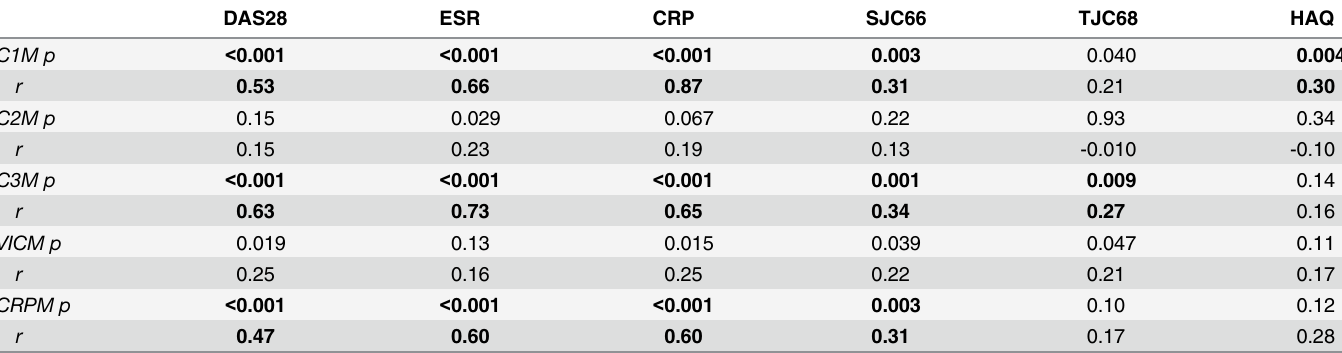
The correlations between the biomarkers of joint destruction and in fl ammation and measures of clinical disease activity were assessed in the overall population (UA+RA) at baseline. UA = unclassi fi ed arthritis; RA = rheumatoid arthritis; DAS28 = disease activity score in 28 joints; ESR = erythrocyte sedimentation rate; CRP = C-reactive protein; SJC66 = 66 swollen joint score; TJC68 = 68 tender joint score; HAQ = health assessment questionnaire;